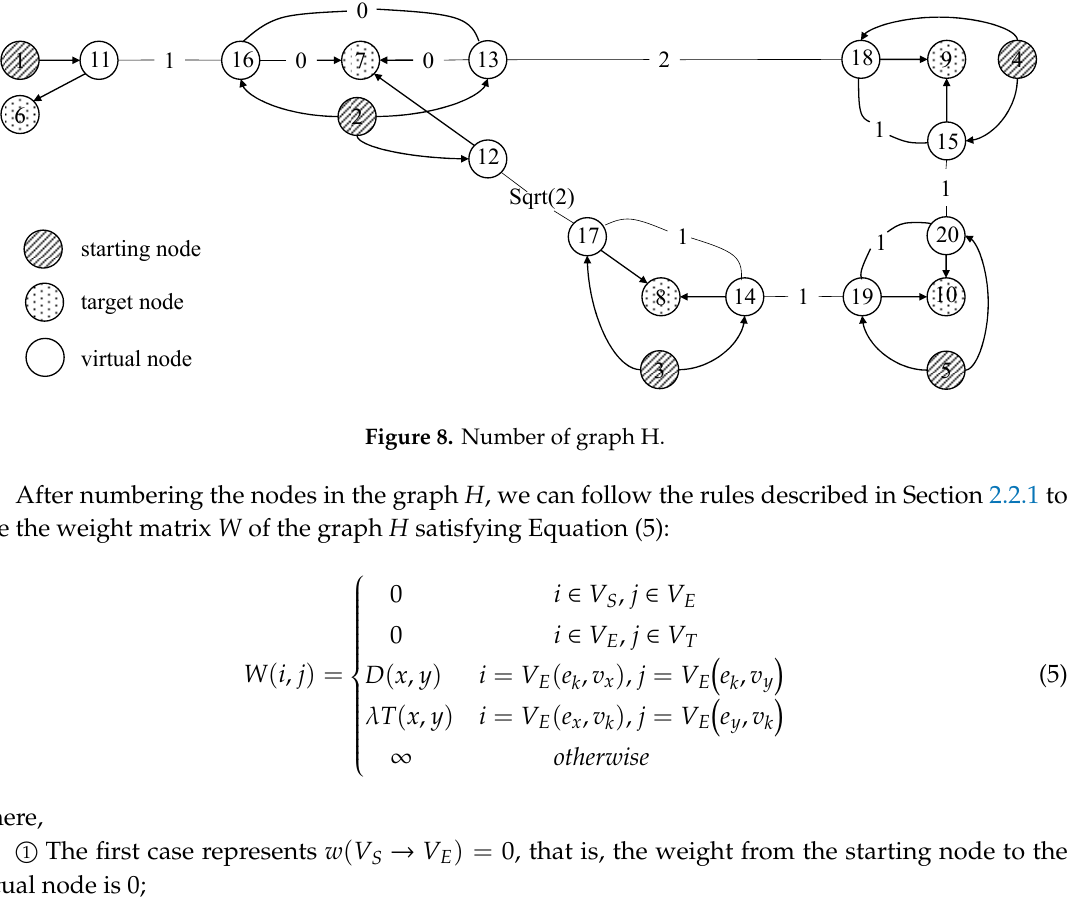
Figure 7. Number of graph G.